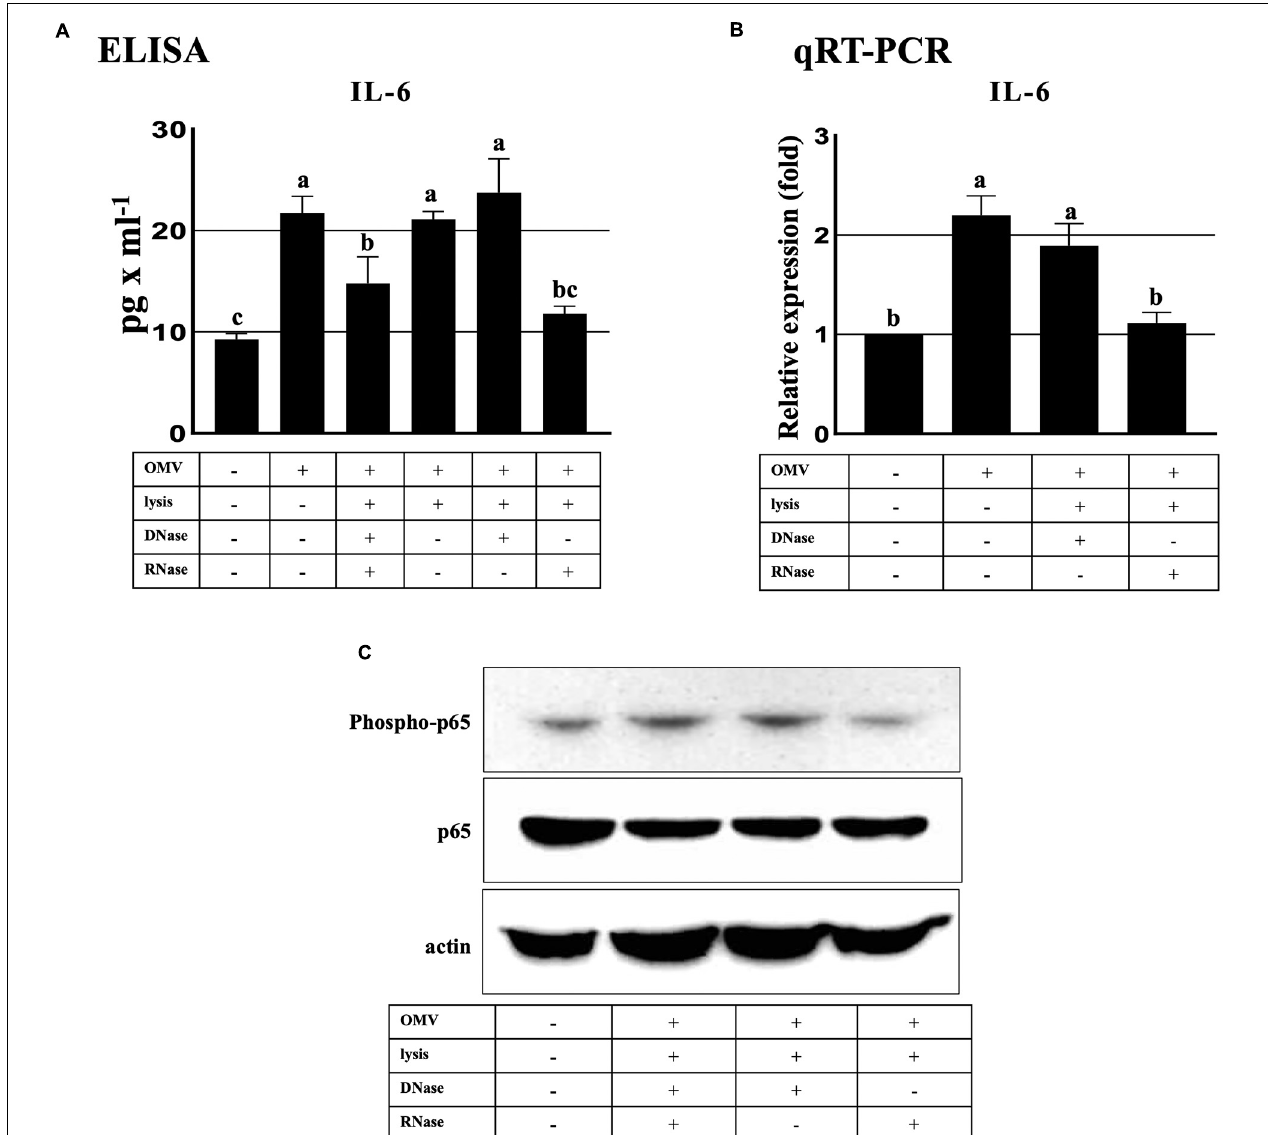
FIGURE 5 | ExRNAs of Aa activate IL-6 in BV2 cells through the NF- κ B signaling pathway. (A) Secreted IL-6 protein levels were upregulated at 16 h after treatment with intact OMVs. IL-6 secretion by OMV lysate was decreased by RNase-only treated OMV lysates in BV2 cells at 16 h. (B) qRT-PCR analysis revealed that the transcript levels of IL-6 activation by Aa OMV lysates were decreased by RNase-only pretreatment at 16 h. (C) NF- κ B activation (phosopho-p65, upper panel) was significantly decreased by RNase-only-treated OMV lysates compared with DNase-treated OMV lysates at 16 h. Total NF- κ B p65 (middle panel) and actin (bottom panel) levels were assessed for controls. BV2 cells were seeded onto 6-well plates (5 × 10 5 cells/well) and treated with Aa OMVs (approximately 4.5 × 10 8 particles/well in 2 ml of media) and OMV lysates (the same amount of proteins as in 4.5 × 10 8 OMV particles). Data are presented as mean ± SD from three independent experiments. The letters (a–c) indicate significant differences at p <